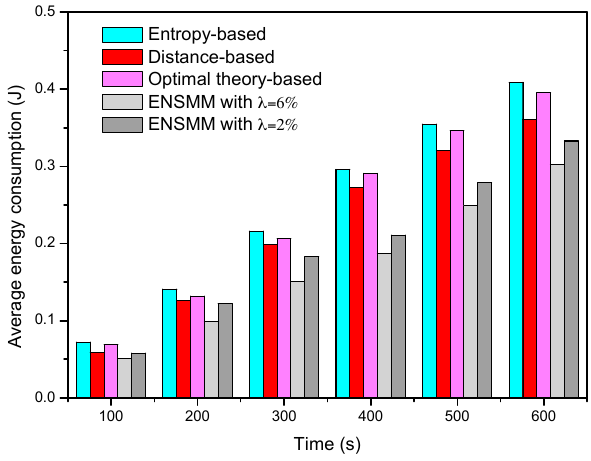
Figure 6. The average energy consumption in surveillance stage.